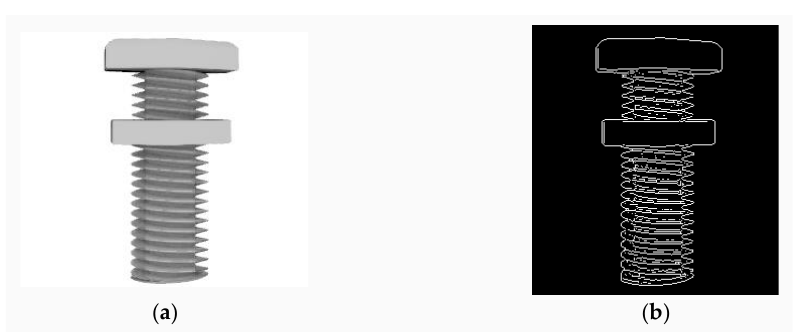
Figure 6. Canny edge feature. ( a ) Screw projection view, ( b ) screw edge extraction map.